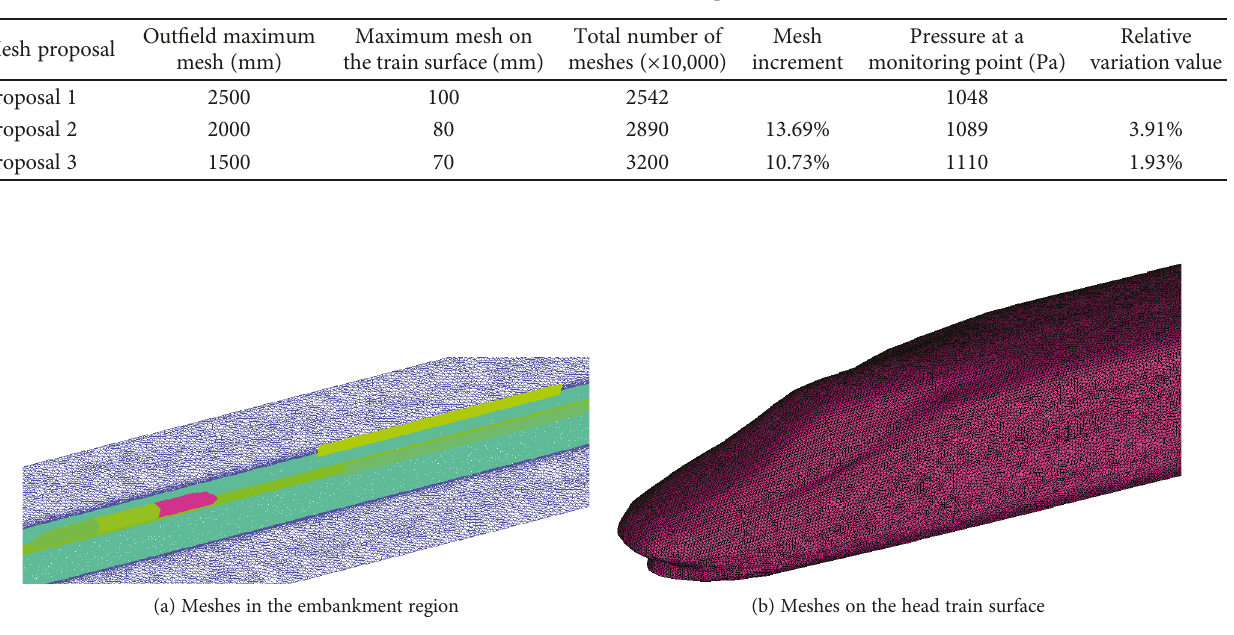
Figure 6: Two di ff erent regions for high-speed train passing the embankment air barrier. Table 1: Veri fi cation of mesh independence.